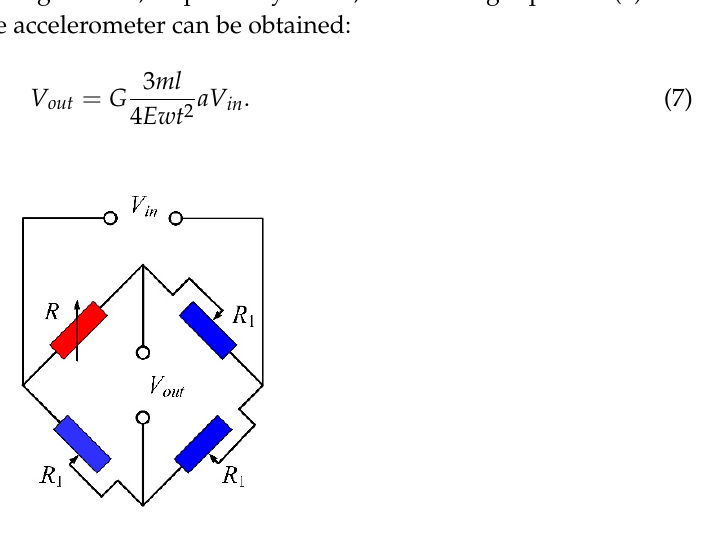
Figure 3. Schematic of the Wheatstone bridge circuit used in the proposed accelerometer. Equation (7) indicates that the output voltage of the accelerometer and the applied acceleration are linearly related to each other. Therefore, by measuring the output voltage of the accelerometer, the value of the acceleration to be measured can be